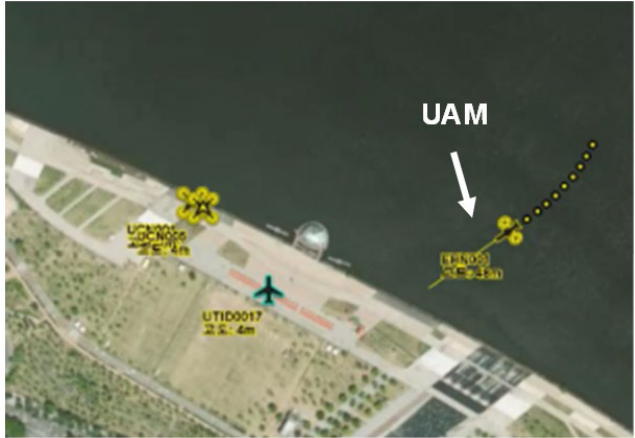
Figure 4. Identified UAM and drones in UTM system.